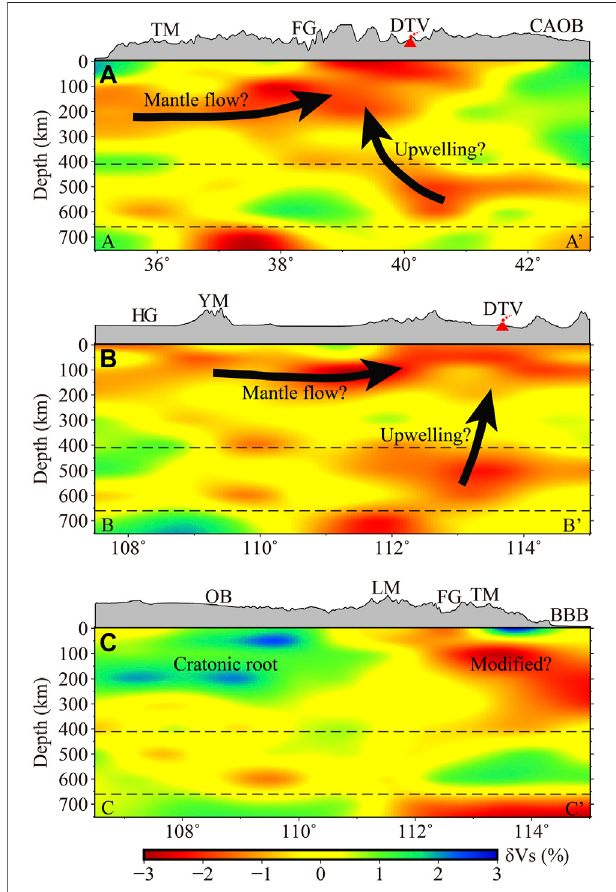
FIGURE 5 | Vertical sections (A – C) of S wave velocity along the pro fi les shown in Figure4B . Thesurfacetopographyofeach section isplotted onthe top of each fi gure. The black thick arrows suggest the possible asthenospheric upwelling and mantle fl ows. The dashed lines indicate the 410 and 660 km discontinuities. The abbreviations are the same as those de fi ned in the caption of Figure 1 .